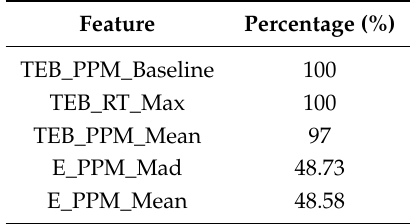
Table 5. Features selected more than 20% in all experiments for